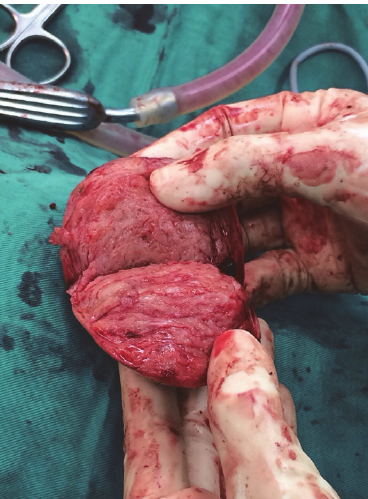
Figure 5: Cut section of enlarged left horn of the